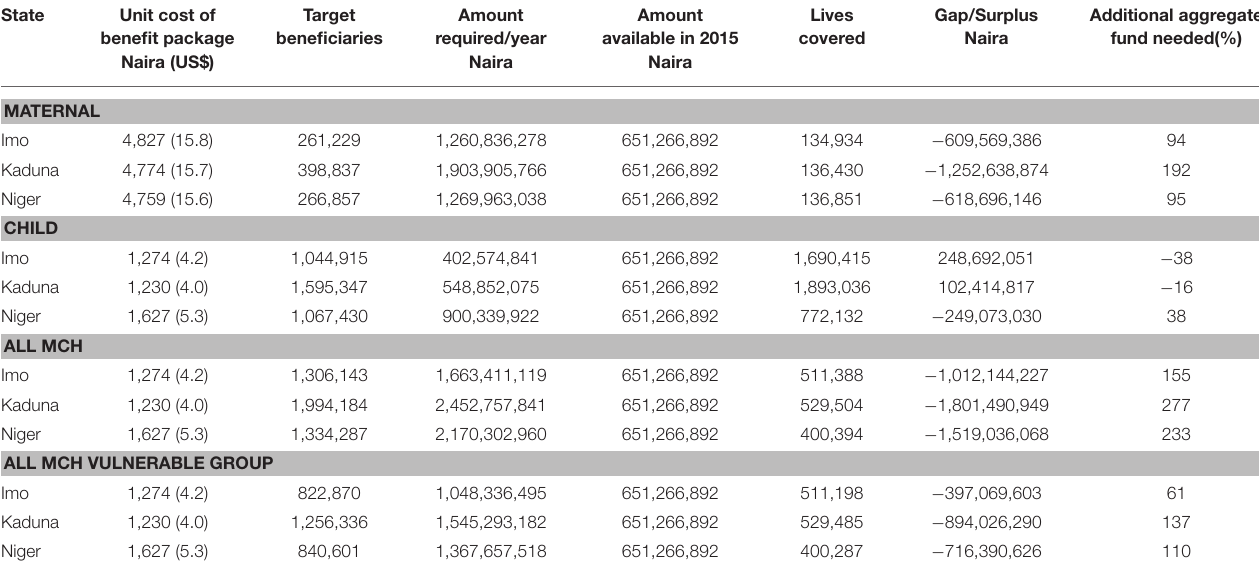
TABLE 8 | Scenario: 1d (Revenue: 50% of BHCPF plus counterpart fund (0.25 of 50%). State